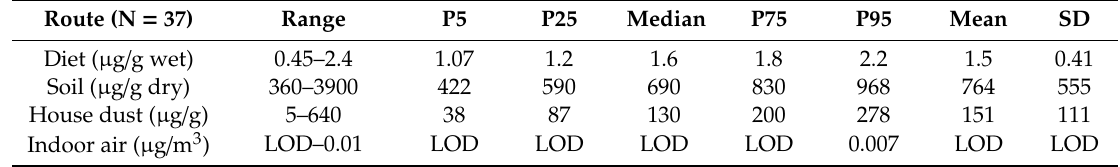
Table 4. Summary on Mn concentrations according to the exposure route.